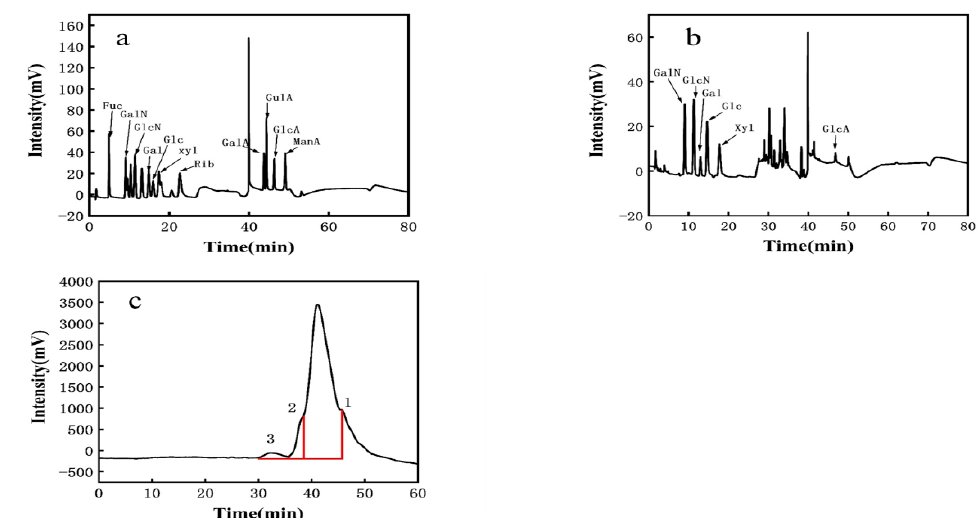
Figure 2. ( a ): The HPLC chromatograms of monosaccharides standard; ( b ): the HPLC chromatograms of PW-7 EPS; ( c ): GPC analysis of EPS.